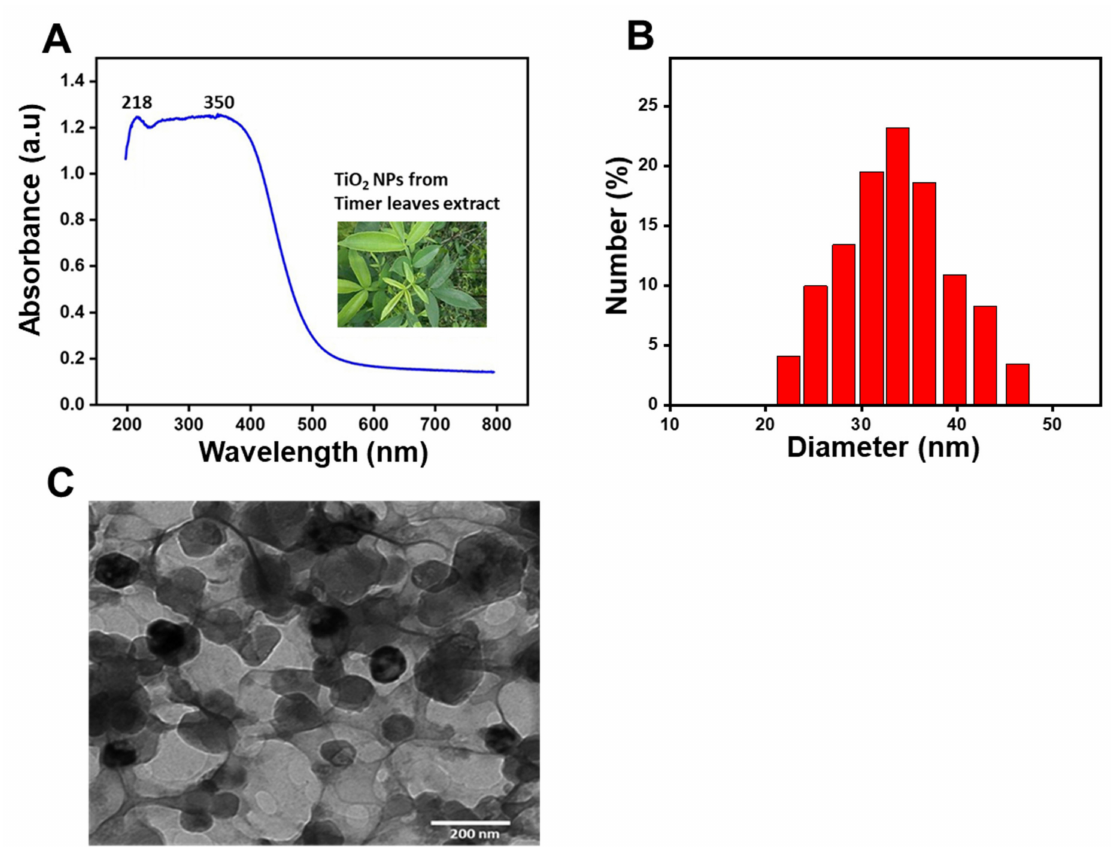
Figure 2. ( A ) UV–Visible spectrum of synthesized TiO 2 NPs using timer leaf extracts; ( B ) Histogram showing the size distribution of the green TiO 2 NPs assessed by DLS; ( C ) TEM image of the green TiO 2